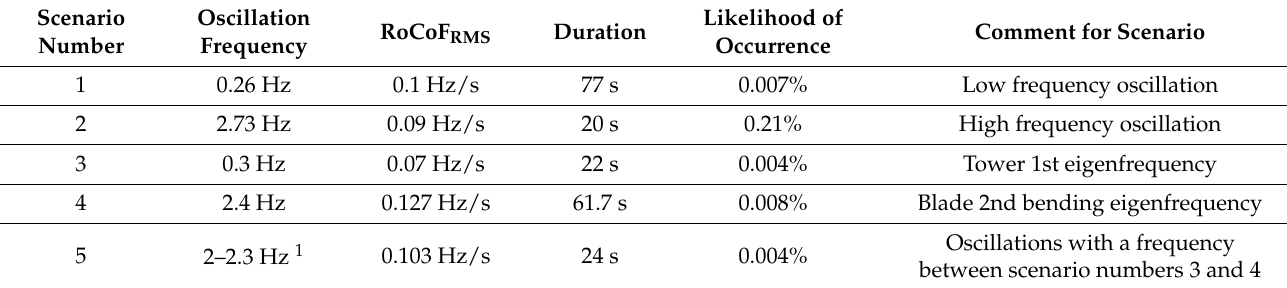
Figure 4. Number of detected periods with grid frequency oscillation with respect to the binned oscillation frequency (bin width 0.2 Hz). Number of the scenario, which represents the accumulated oscillations. Table 1. Overview of identified scenarios to represent grid frequency oscillation in the load analysis.